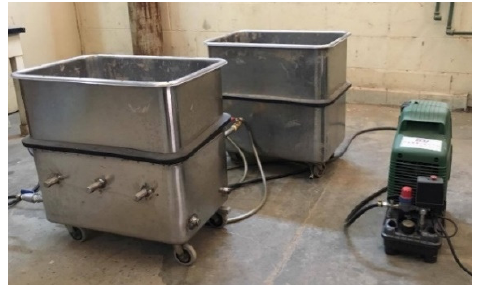
Fig. 1. The pilot-scale stainless steel tanks of Biopile system.